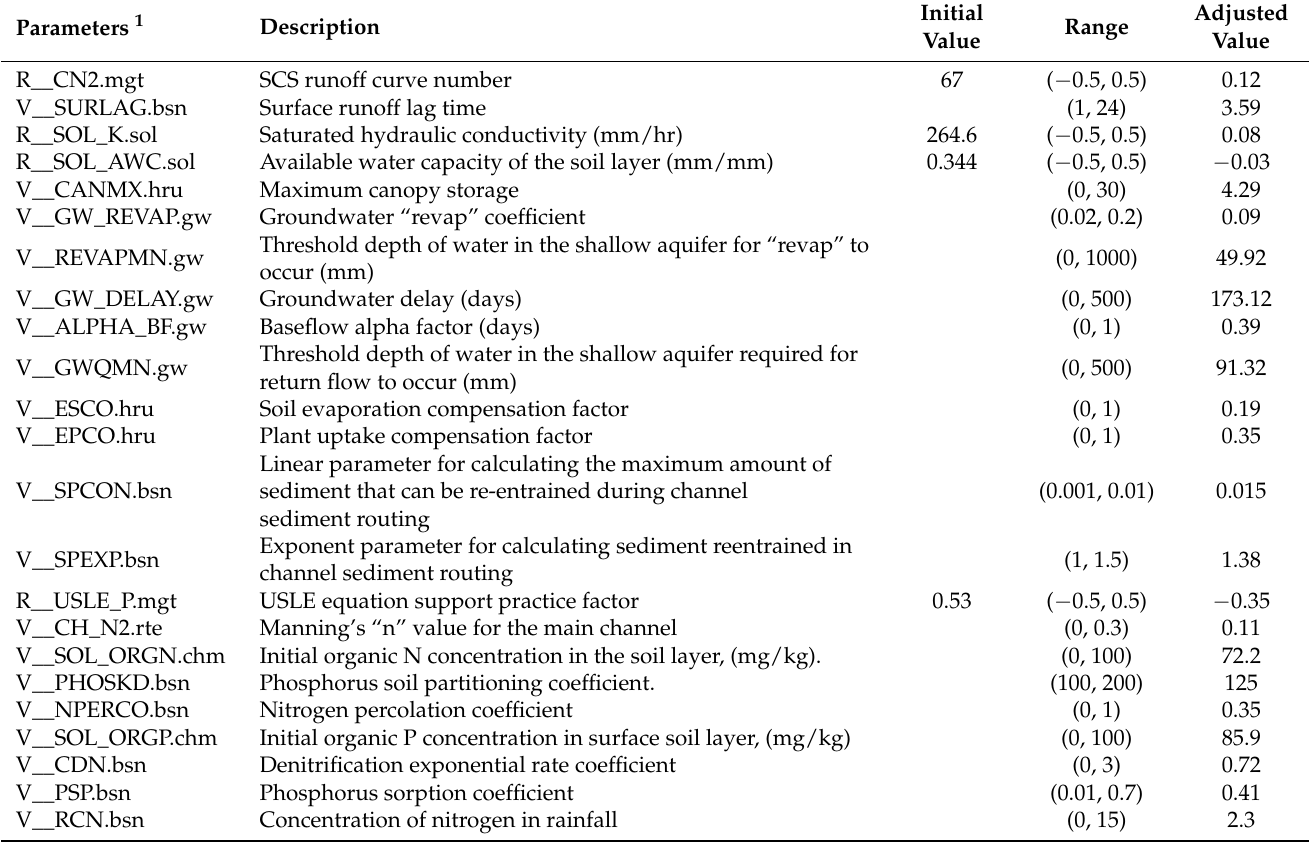
Table A1. Ranges and calibrated values of the sensitive parameters selected in this SWAT model. Parameters